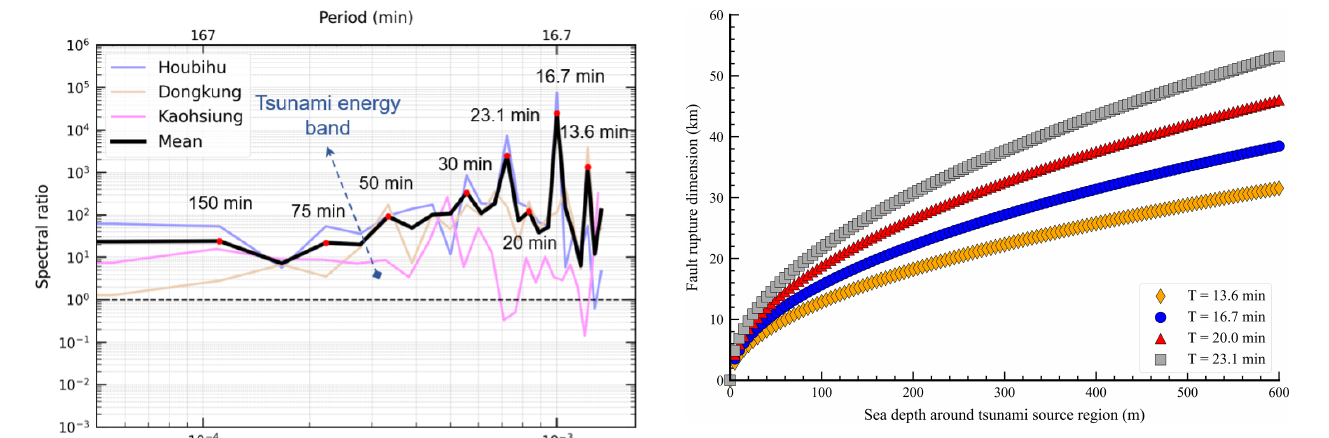
Figure 12. Correlation of earthquake fault dimensions and sea depth around the tsunami source region derived from the empirical for- mula proposed by Rabinovich